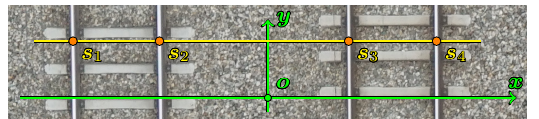
Figure 7. Railroads Distance. Let s k = ( s k , 1) for k = 1 , 2 , 3 , 4 such that in a local coordinate system with origin o = (0 , 0) the distances s 2 − s 1 = s 4 − s 3 = g are the known distance between two rails on a railroad in world units (e.g. g = 1 . 5 m) and s 3 − s 1 = s 4 − s 2 = d are the unknown distance between the